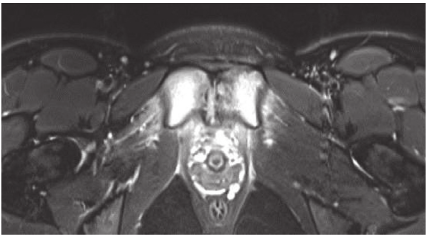
Figure 1: MR image when the patient relapsed with pain.